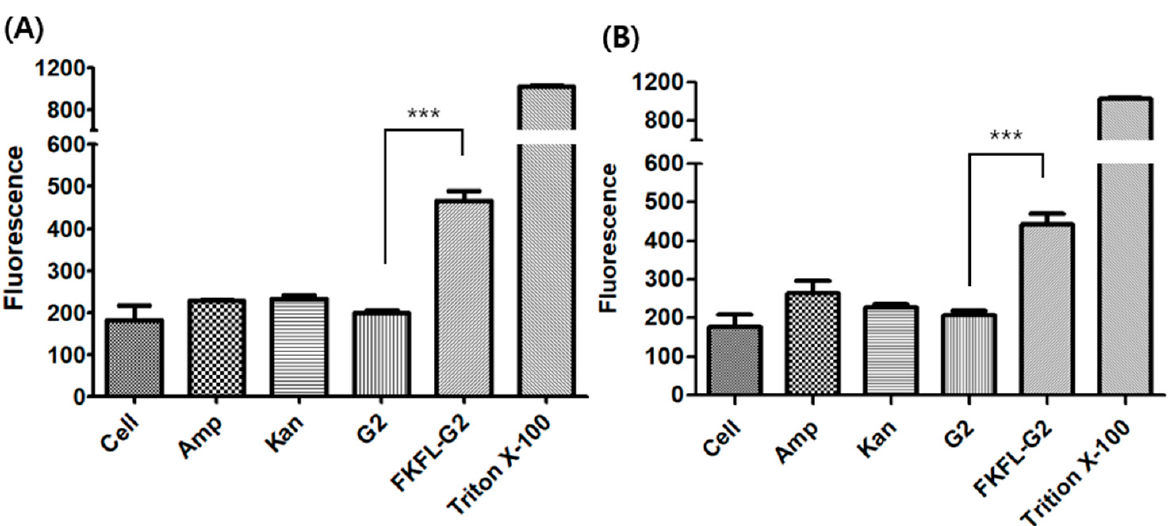
Figure 6. N-phenyl-1-naphthylamine assay results in illustrating the effect of TritonX-100, FKFL-G2, second-generation polyamidoamine (G2 PAMAM), kanamycin (Kan), and ampicillin (Amp) on the membrane of ( A ) E. coli and ( B ) S. aureus . Results are presented as the mean ± SD ( n = 3). Statistical analysis of the experimental data was performed by the Student’s t -test using the GraphPad Prism 5 program (***, p < 0.001).